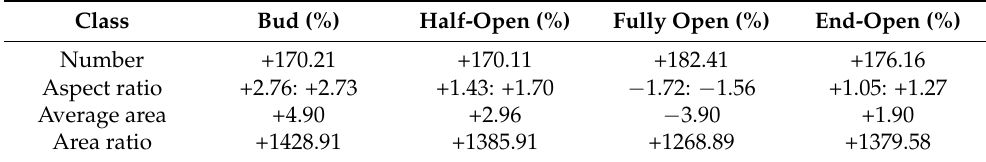
Table 5. Changes in annotated data information after SAHI algorithm slicing.